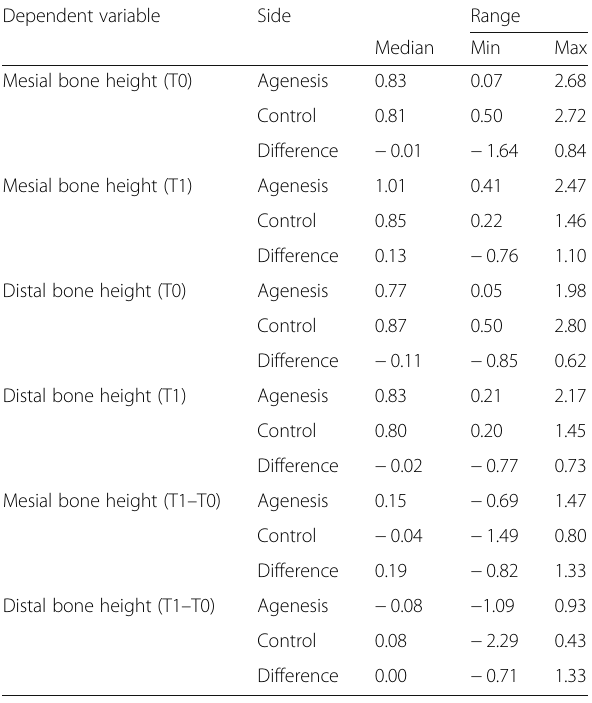
Table 3 Non-parametric MANCOVA on molar angulation at different treatment statuses (pre- or post-treatment), and side memberships (space closure or